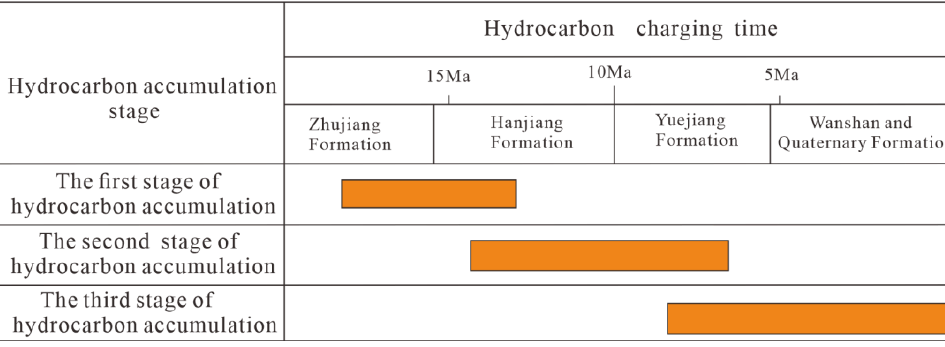
Table 1. Identification of hydrocarbon accumulation table based on reservoir fluid inclusions and Ar isotope dating.